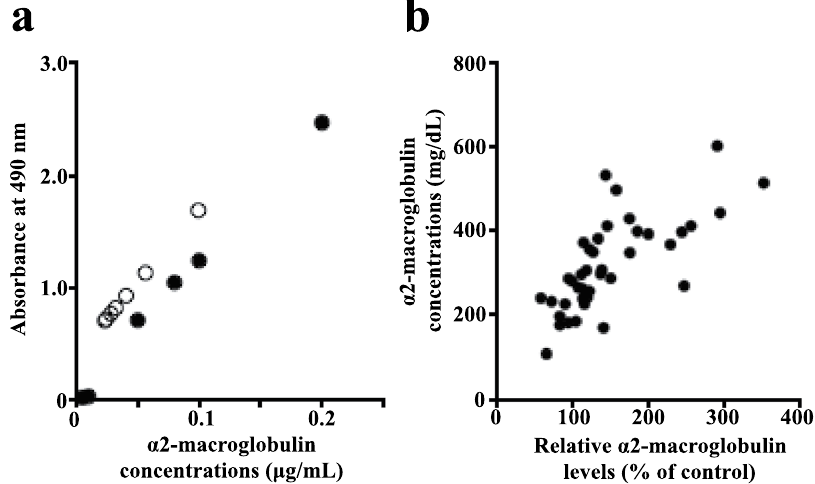
Figure 2. α 2 -macroglobulin ELISA. ( a ) Parallelism of the dilution curve generated by normal human serum serially diluted to 1:40000, 1:80000, 1:120000, 1:160000, 1:200000, 1:240000, and 1:320000 (open circles) with the human α 2 -macroglobulin standard regression curve (closed circles). ( b ) Serum α 2 -macroglobulin levels of 40 DM patients were determined using quantitative western blotting and by ELISA, and the two values were plotted to observe potential correlations.